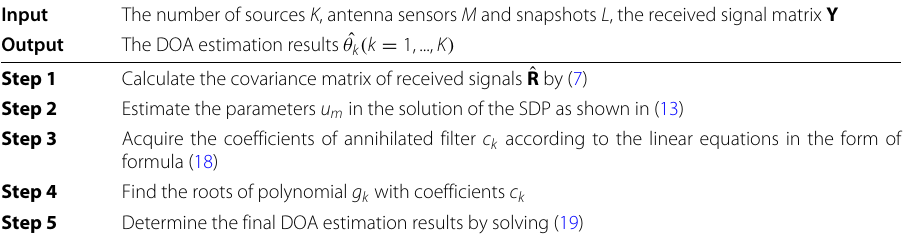
Table 1 The process of proposed